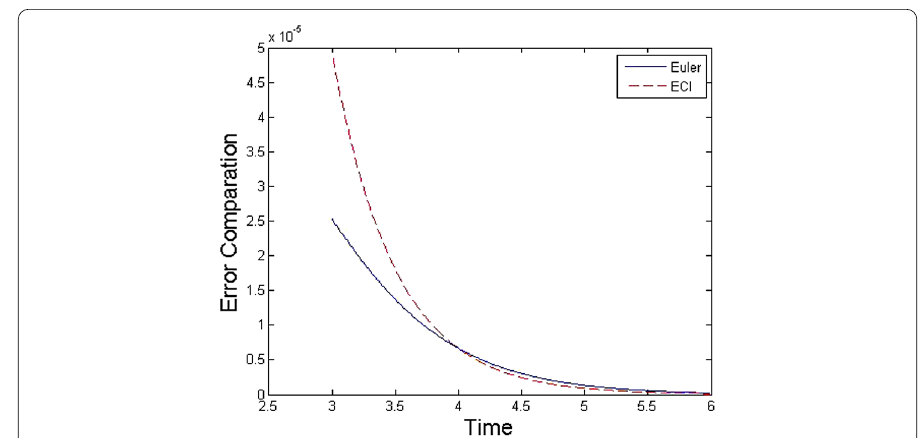
Figure 5 Comparison of errors from Euler scheme and ECI algorithm